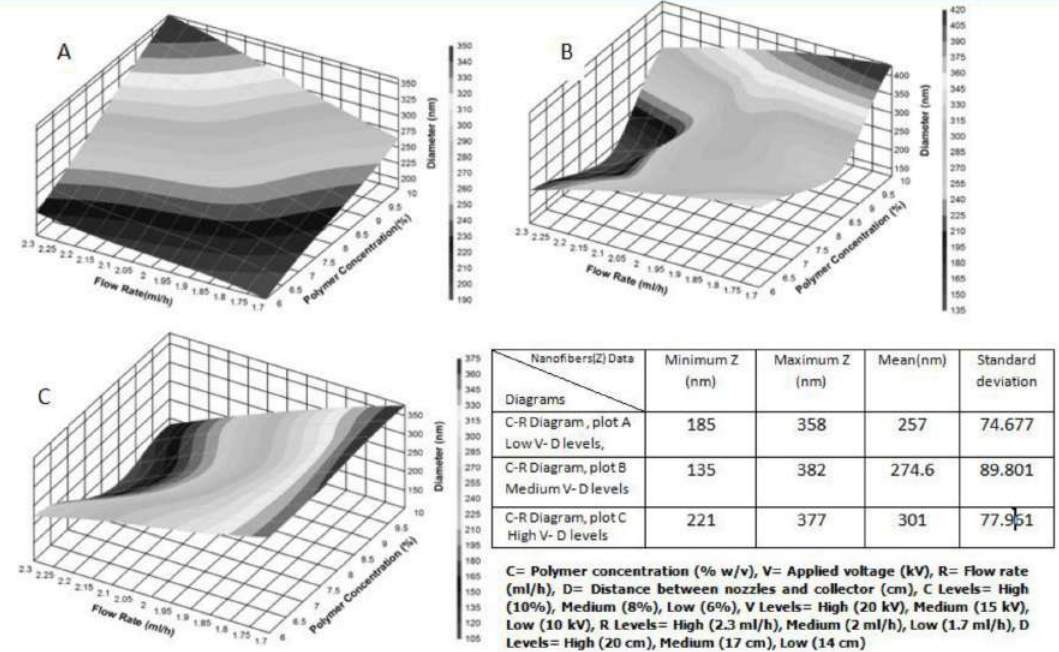
Fig. 4. The data and 3 D plots of nanofibers diameter predicted by ANN fixed in mentioned levels (C-R